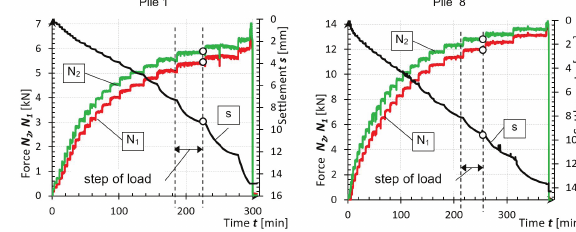
Figure 4. Each load step gives two pair of points ),(